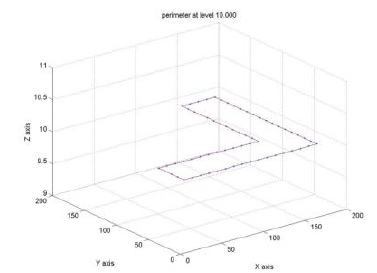
Figure 21. Classic perimeter for a chain (level 10.000)